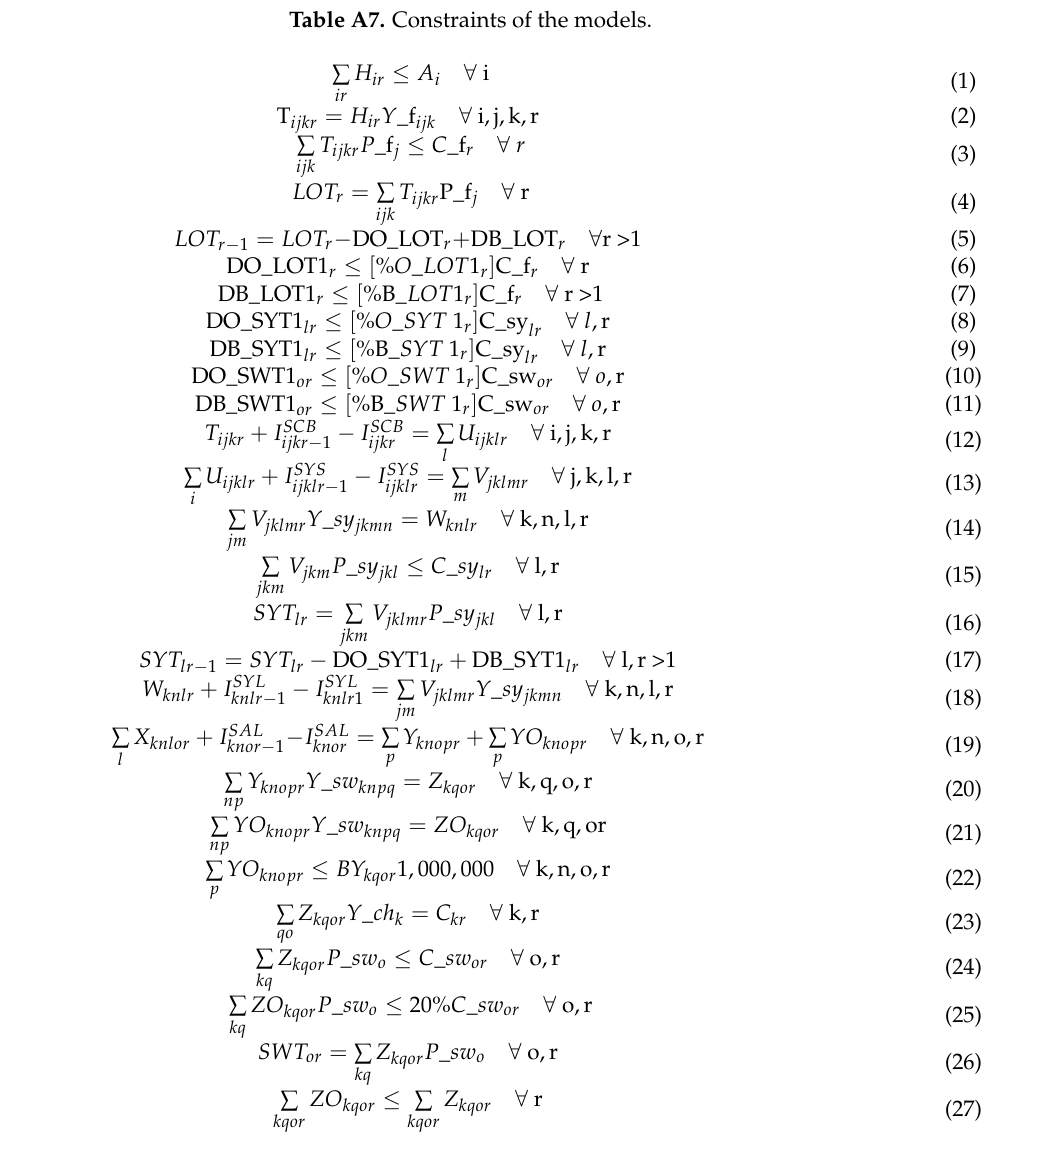
Table A7. Constraints of the